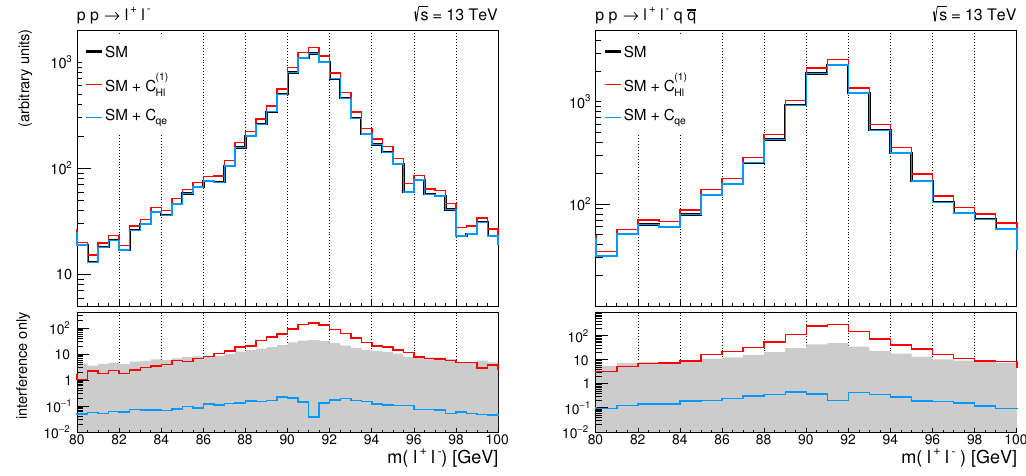
Figure 6 . Left: invariant mass distribution of the ‘ + ‘ (cid:0) pair from Drell-Yan production (pro- cess (i)). Right: invariant mass distribution of the ‘ + ‘ (cid:0) pair from process (ii). The top panels show the complete spectra obtained in the SM limit and in the presence of one e(cid:11)ective operator with C i = (cid:3) 2 = 1 TeV (cid:0) 2 (only the interference term is retained in these cases). The black and blue lines are overlapping in the right (cid:12)gure. The lower panels show the absolute size of the pure SM{ interference term for each operator (colored lines) compared to the statistical uncertainty on the SM distribution (grey